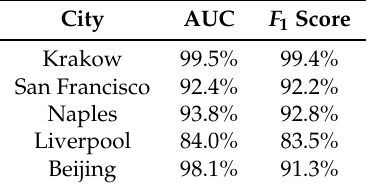
Table 3. The best AUC and F 1 score values for selected